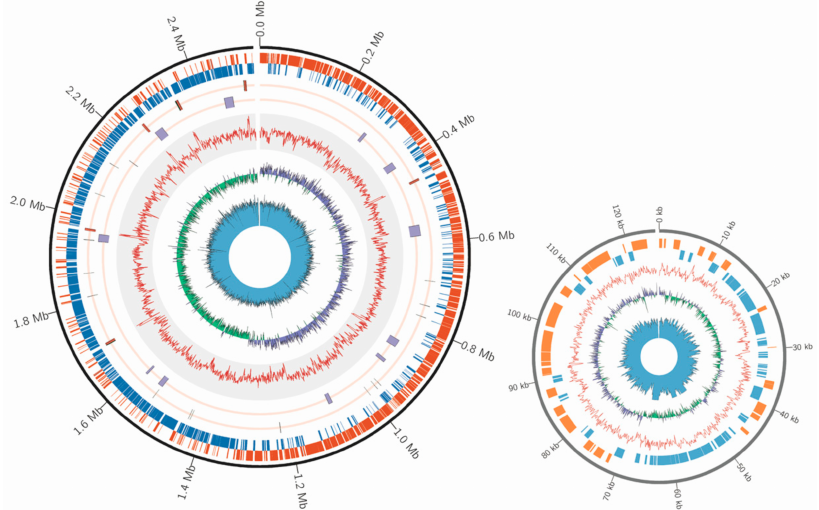
Figure 1. Genome organization of the E. faecium H7 strain. Circular overview of the complete chromosome (left panel) and plasmid (right panel) of the E. faecium H7 strain. In the chromosome, starting from the outside ring towards the interior: CDS in sense strand (orange) and antisense strand (blue); 6 copies of the ribosomal operon (rRNA, red) and tRNA (black); genome island (purple) and CRISPR (black); GC content (red); GC-skew (+, purple; − , green); sequencing depth (blue). In the plasmid, starting from the outside ring towards the interior: CDS in sense strand (orange) and antisense strand (blue); GC content (red); GC-skew (+, purple; − , green); sequencing depth (blue).